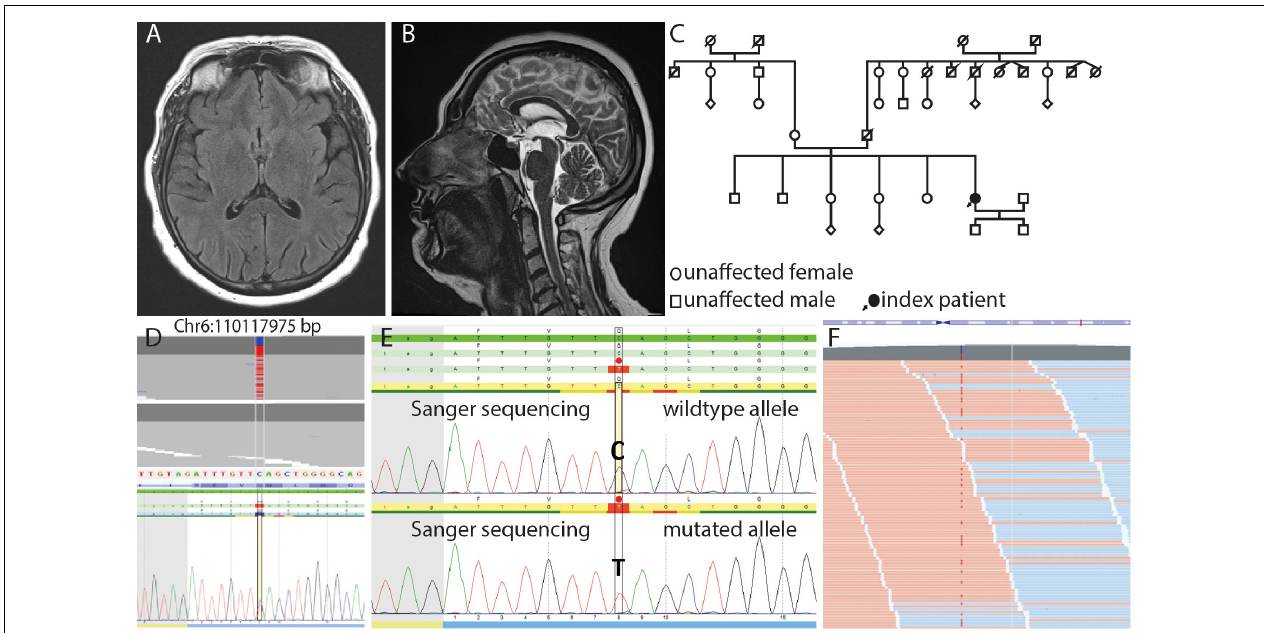
FIGURE 1 | Axial FLAIR (A) and sagittal T2w (B) images show no morphologic features of neurodegeneration or structural damage to the brain. (C) Pedigree of the family. Note that information on clinical symptoms of the patients’ relatives was available only until her age of 20 years. (D) JSI-Sanger data with the heterozygous variant in FIG4 compared to in-house next-generation sequencing (NGS) data, showing this variant in heterozygous state (upper part) and randomized in-house reference pool, which shows the absence of this variant in wildtype (lower part). (E) DNA sequence of the wild-type and mutated allele containing the substitution c.2467 C > T, which leads to the nonsense variant p.Q823* on protein level (red dot) in FIG4. (F) Mapped sequencing reads show the variant on forward (orange) and reverse (blue) strand in approximately 50% of the reads, which is expected for heterozygosity with a sequencing depth (coverage) of more than 500 reads per